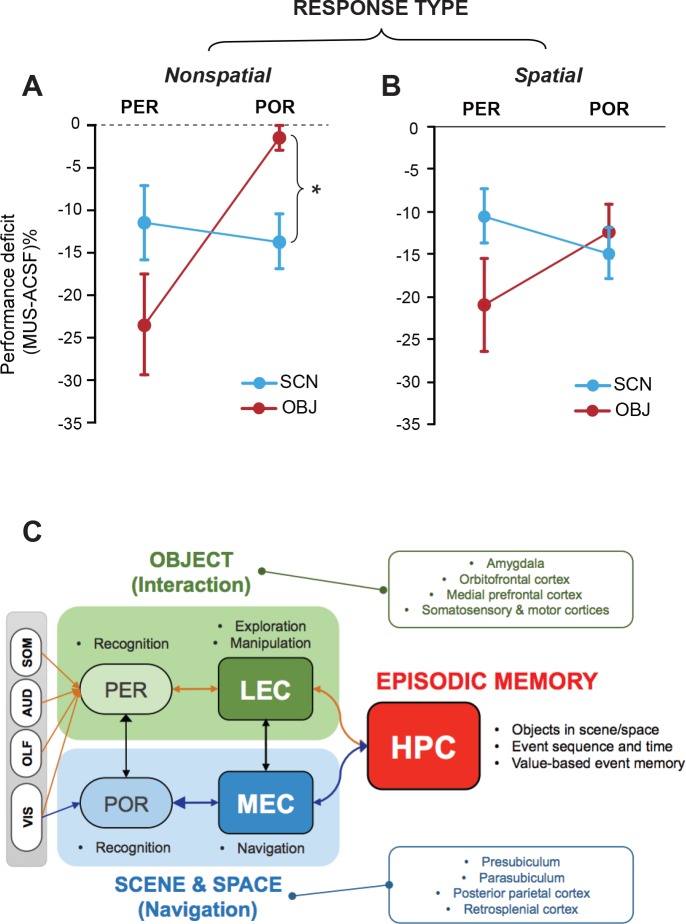
Lack of stimulus-response interaction in the PER and POR and a theoretical model.(A) Performance deficits (calculated by subtracting the ACSF-based performance from the MUS-based performance) in the nonspatial response tasks (Mean ± SEM). The POR-MUS condition resulted in significant deficits in performance when scenes were used as cues, but not when objects were used. The PER-MUS condition produced deficits in using scenes and objects for making nonspatial choices with bigger deficits with object cues. (B) Performance deficits in the spatial response tasks (Mean ± SEM). Both PER-MUS and POR-MUS conditioned produced similar levels of impairment observed in the nonspatial tasks (A), suggesting the lack of scene-response interaction at the PER and POR level. Furthermore, the more prominent roles of the PER, but not the POR, in the object-cued task was also observed in the spatial response tasks. *p<0.025. (C) A working model for information processing in the medial temporal lobe. Multimodal sensory inputs (VIS: visual, OLF: olfactory, AUD: auditory, SOM: somatosensory) are provided to the PER, and only visual inputs are fed to the POR. The PER and POR process these inputs to recognize objects and scenes, respectively. The LEC is involved in remembering choice responses associated with objects, whereas the MEC represents navigation-related variables using visual scene information from the POR. The LEC is reciprocally connected to the PER, hippocampus, insular cortex, and frontal areas (Burwell and Amaral, 1998a). Also, the LEC projects to the basal ganglia, medial prefrontal cortex, somatosensory cortex, and motor areas (Swanson and Köhler, 1986). The MEC has reciprocal connections with the POR, hippocampus, cingulate, and parietal cortex (Burwell and Amaral, 1998b). The MEC receives projections from the parasubiculum and postsubiculum (Canto et al., 2008). In this model, the PER-LEC networks are to interact with objects and the POR-MEC networks process information to navigate in space. In the hippocampus, the neural representations from these two channels are temporally structured with relative values in a goal-directed manner to generate rich episodic memories.